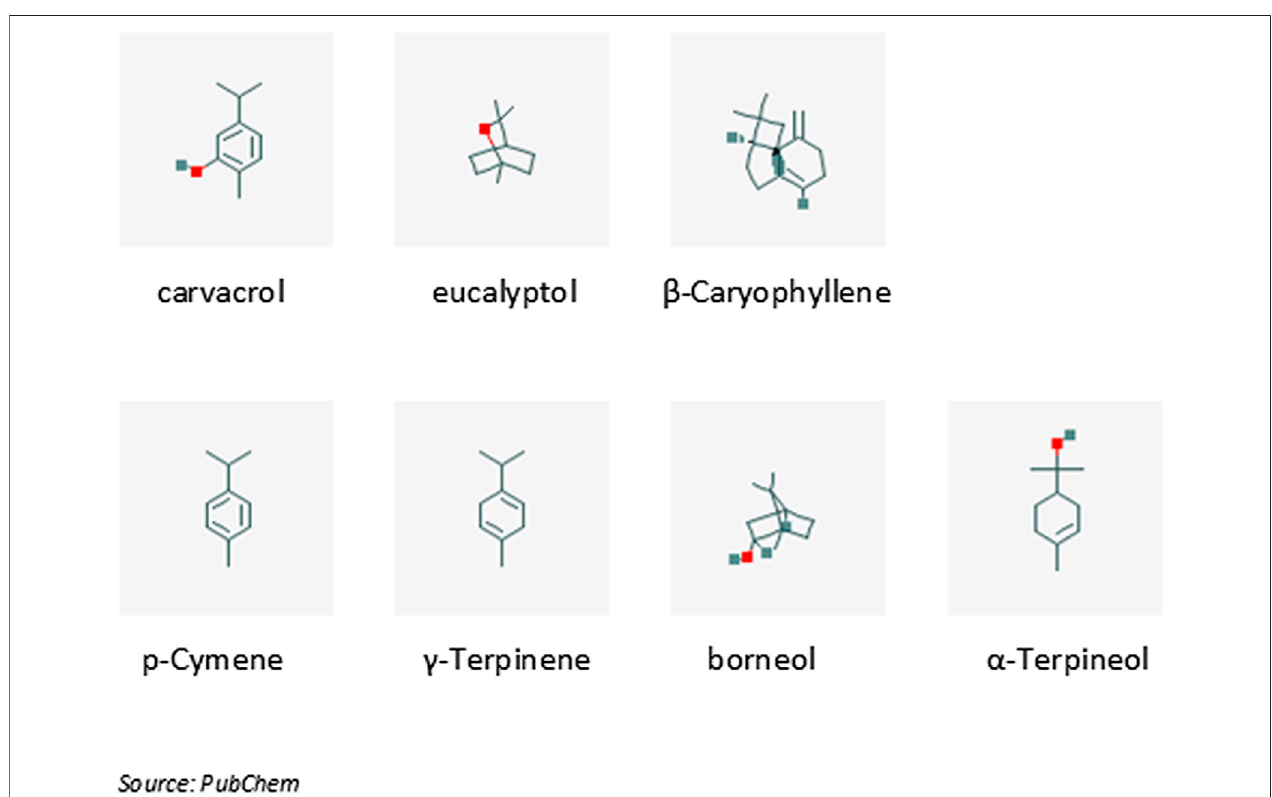
FIGURE 2 | Themainphytochemicalconstituentscontainedintheessentialoilofplantsdiscussedinthisreview.IUPACnames:2-methyl-5-propan-2-ylphenol(carvacrol),1,3,3- trimethyl-2-oxabicyclo[2.2.2]octane(eucalyptol),(1R,4E,9S)-4,11,11-trimethyl-8-methylidenebicyclo[7.2.0]undec-4-ene( β -Caryophyllene),1-methyl-4-propan-2-ylbenzene( p -Cymene), 1-methyl-4-propan-2-ylcyclohexa-1,4-diene ( γ -Terpinene), (1S,2R,4R)-1,7,7-trimethylbicyclo [2.2.1] heptan-2-ol (borneol), 2-(4-methylcyclohex-3-en-1-yl)propan-2-ol ( α